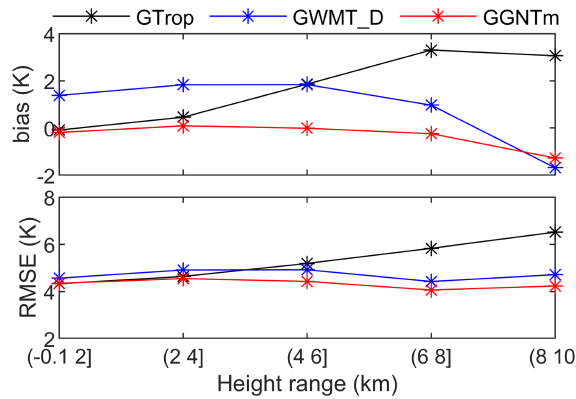
Figure 8. Bias and RMSE of T m from radiosonde profiles at 428 global radiosonde stations in each of five height ranges resulting from GTrop, GWMT_D, and